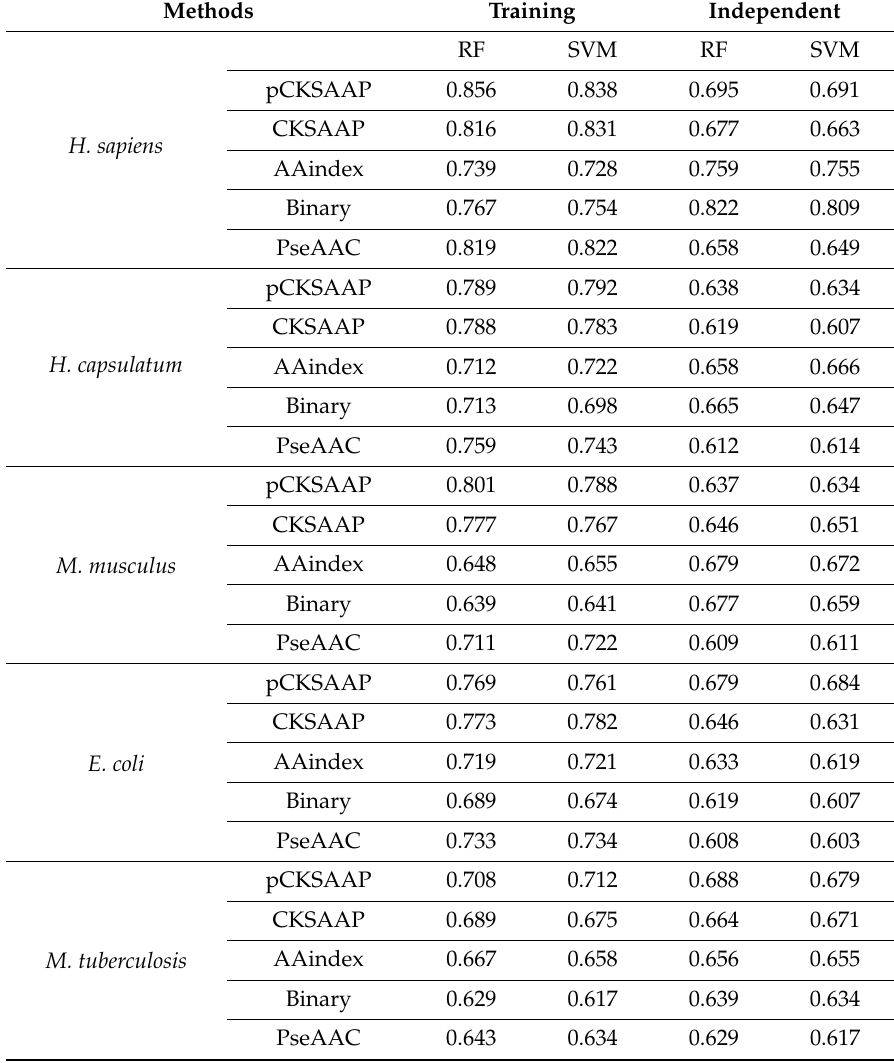
Table 4. Performance of five major types of features for the training and independent